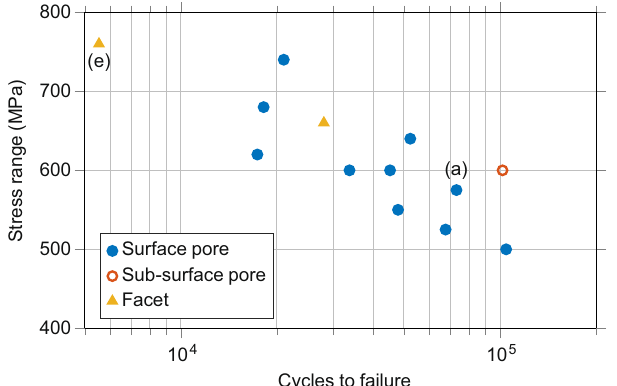
Figure 1. Measured fatigue life of EBM samples. – A S-N curve for uniaxial loading at R = 0 showing the number of fatigue cycles to failure against stress range for samples tested in the z -direction according to ASTM E466-07. Testing was conducted on cylindrical samples, with a gauge diameter and length of 4.5 mm and 12 mm, respectively, and a blend radius of 9 mm. The marker indicates the feature identified at the crack initiation location for each sample, while the letters enclosed in parentheses indicate the corresponding images in Fig.